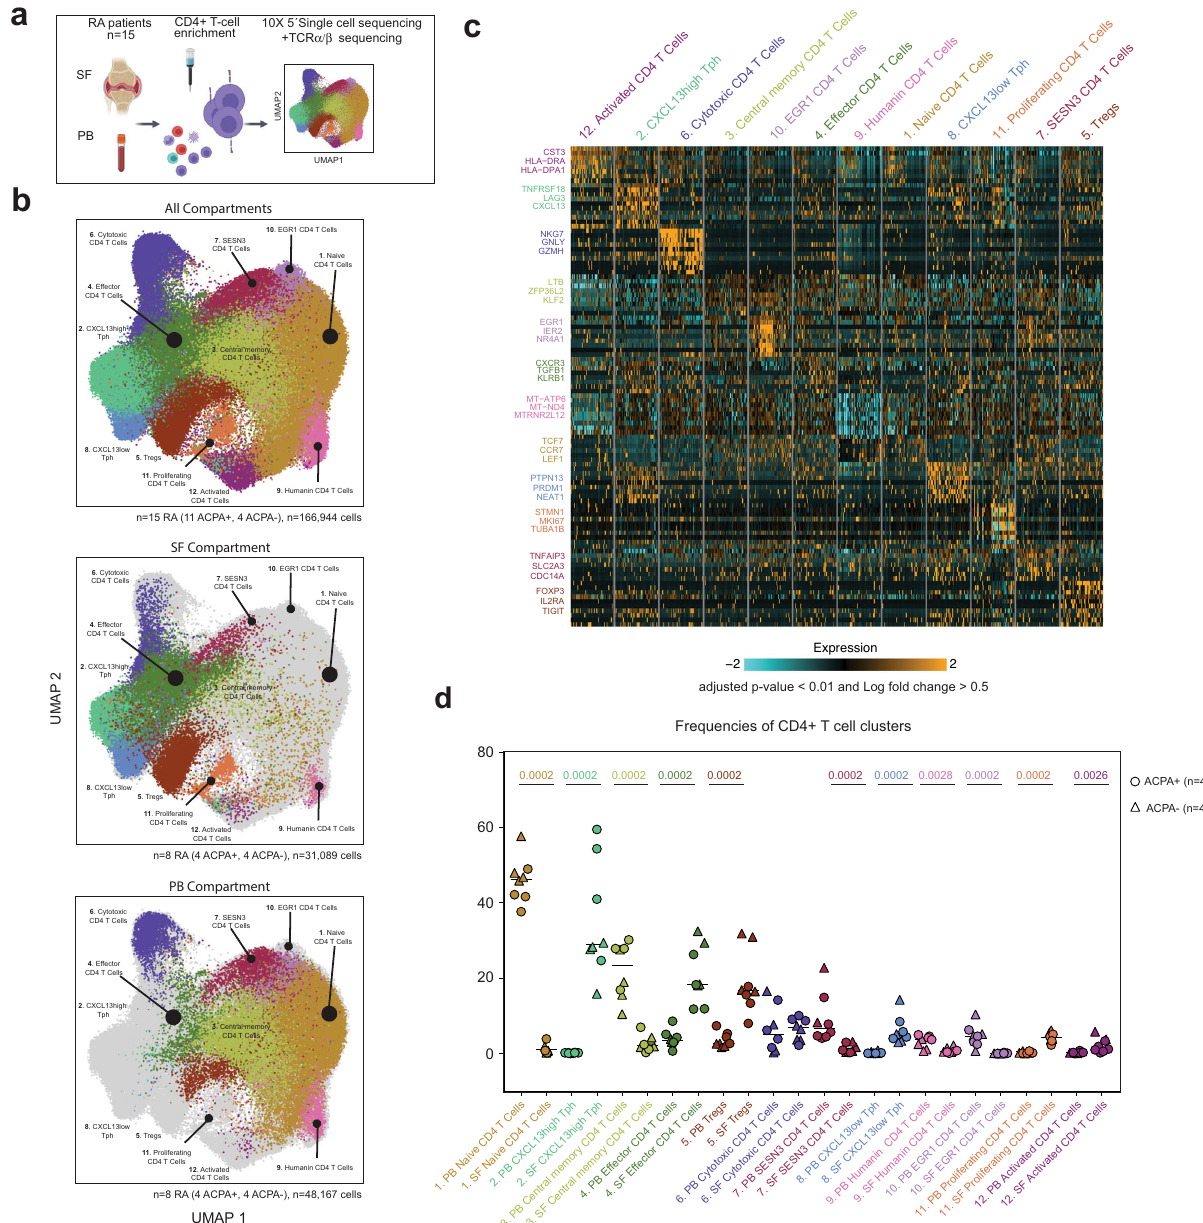
Fig. 2 Single-cell RNA sequencing of CD4 + T cells from SF and PB of RA patients. a Technical work fl ow including CD4 + T-cell enrichment and 10X 5 ′ single-cell sequencing coupled to TCR αβ sequencing on 15 paired PB and SF from RA patients (11 ACPA + , 4 ACPA − ). b UMAP displaying 12 CD4 + T-cell clusters in combined SF and PB (upper panel, n = 15 RA (11 ACPA + , 4 ACPA − ), n = 166,944 cells), SF (middle panel, n = 8 RA (4 ACPA + , 4 ACPA − ), n = 31,089 cells) and PB (lower panel, n = 8 RA (4 ACPA + , 4 ACPA − ), n = 48,167 cells). c Heatmap showing selected differentially-expressed genes (DEGs) in the different CD4 + T-cell clusters in combined PB and SF, P < 0.01, model-based analysis of single-cell transcriptomics (MAST). d Frequencies of CD4 + T-cell clusters in PB and SF from n = 8 RA patients (4 ACPA + , 4 ACPA − ). Circle indicates ACPA + RA patients, triangle indicates ACPA − patients. Line represents median, two-tailed Mann – Whitney U